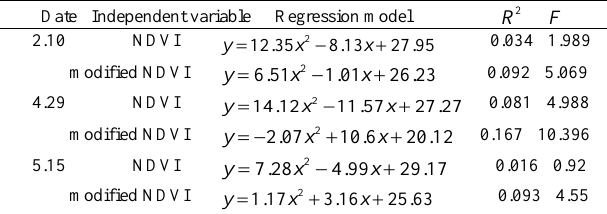
Table 7. 20cm soil moisture regression model in central Henan